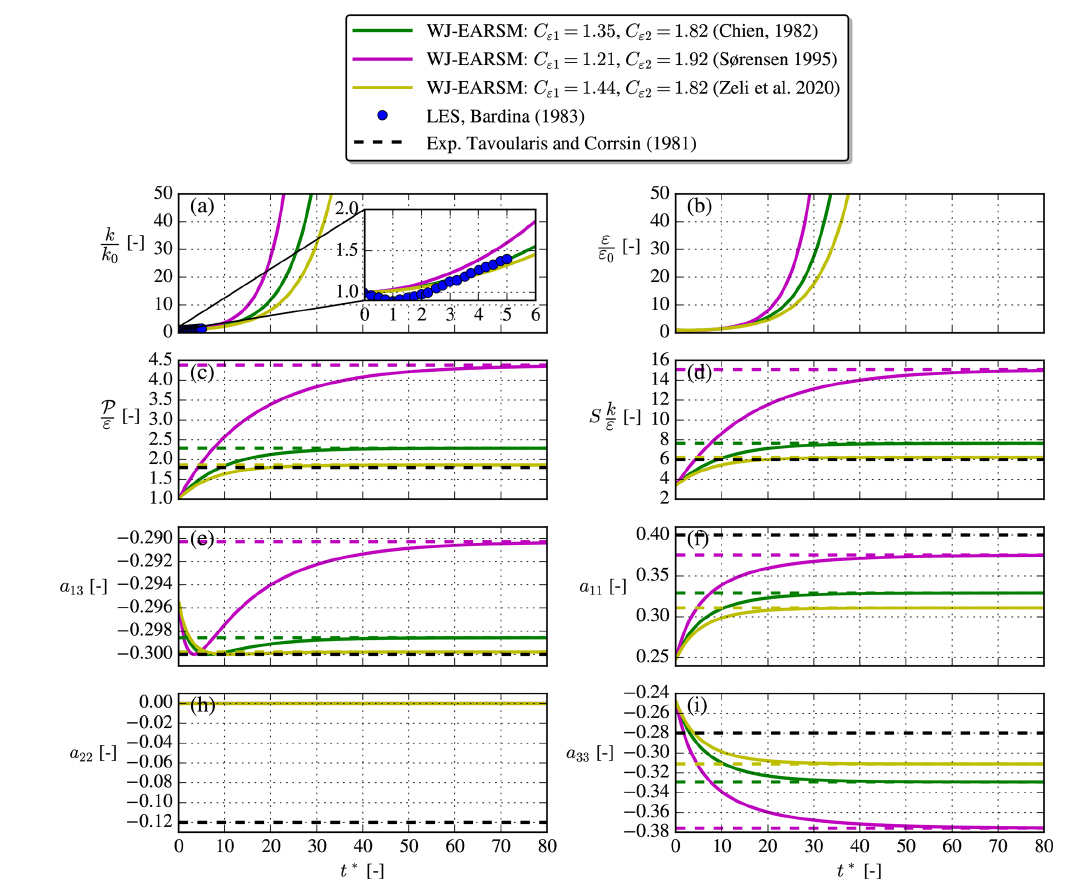
Figure 4. Simulation of homogeneous shear flow with WJ-EARSM (full line) and the model’s analytical asymptotic values (dashed lines) with different sets of constants. The simulation data are extracted at z/L z = 0 . 45, but the evolution is identical at all grid points.